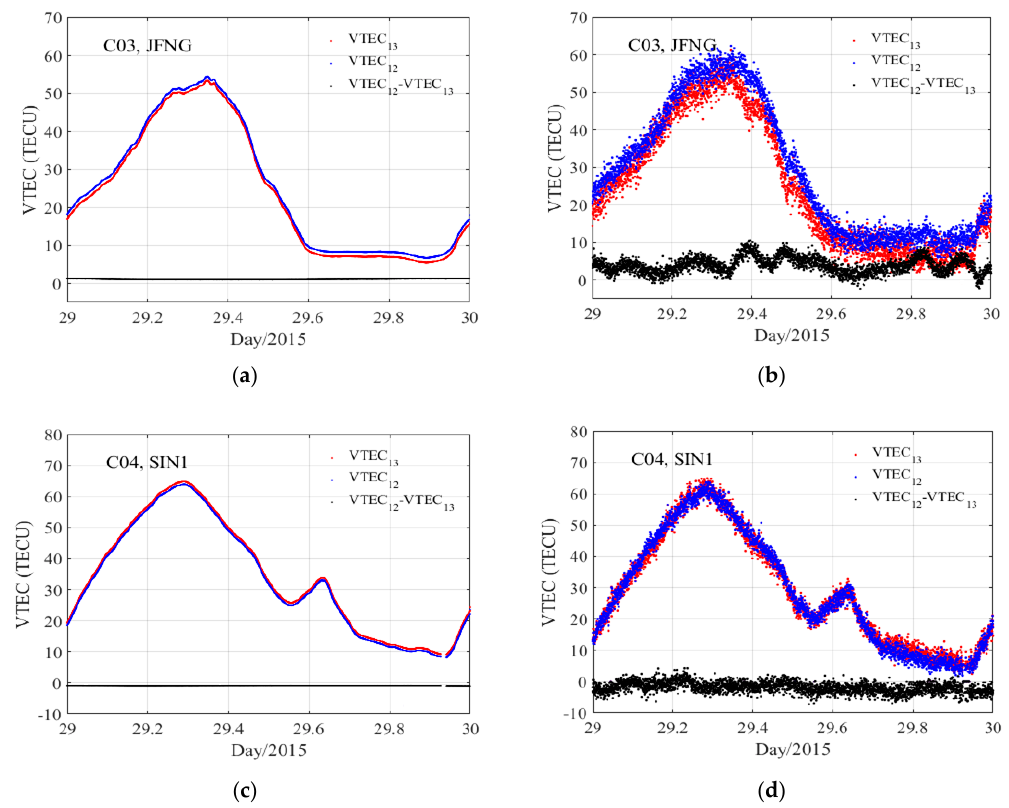
Figure 4. VTEC 12 , VTEC 13 , and the difference between the two groups for GEO satellites on Day 029/2015. Smoothed code: JFNG ( a ), SIN1 ( c ); Code: JFNG ( b ), SIN1 ( d ).